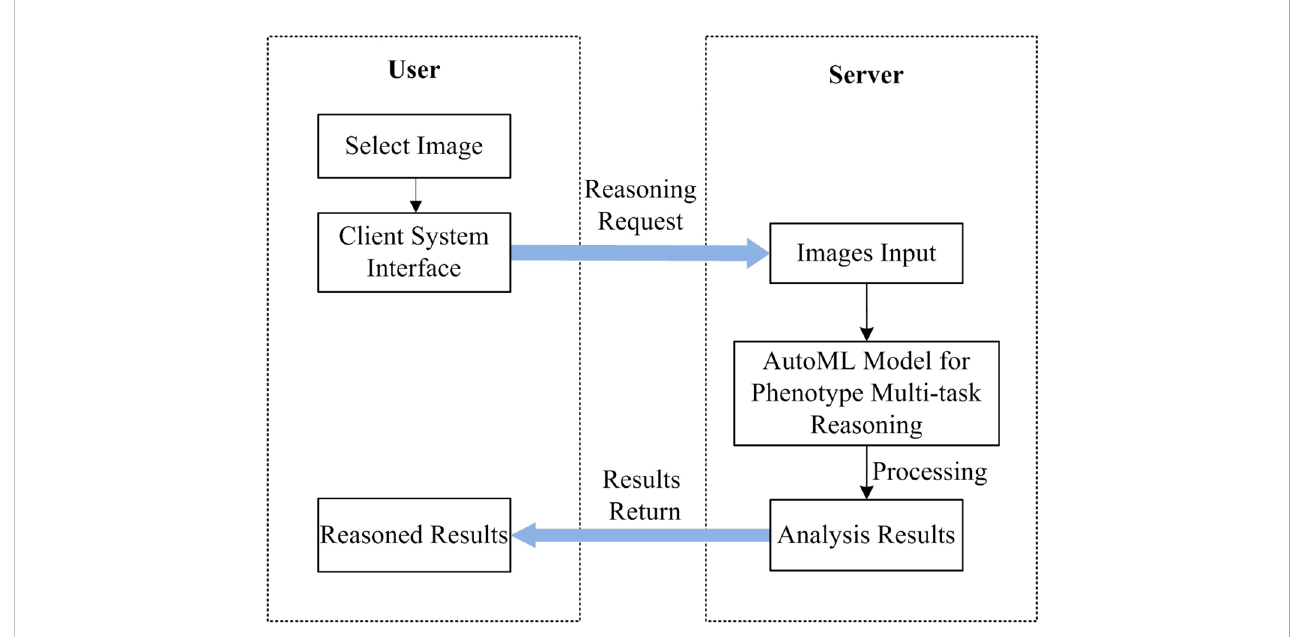
FIGURE 11 Work fl ow of Arabidopsis thaliana phenotype reasoning system based on AutoML.